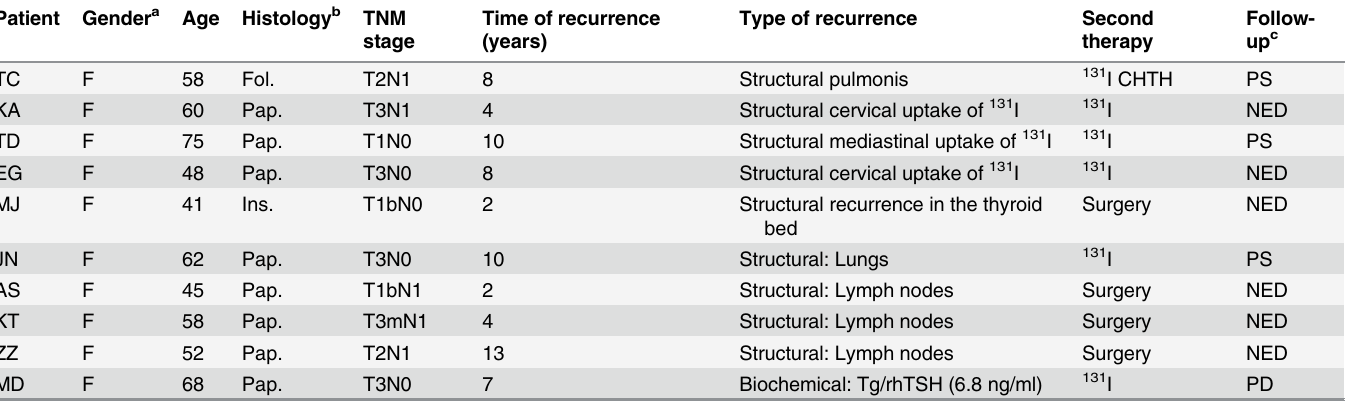
Table 2. Clinical characteristics of ten patients with recurrent disease after successful initial therapy. Patient Gender a Age Histology b TNM